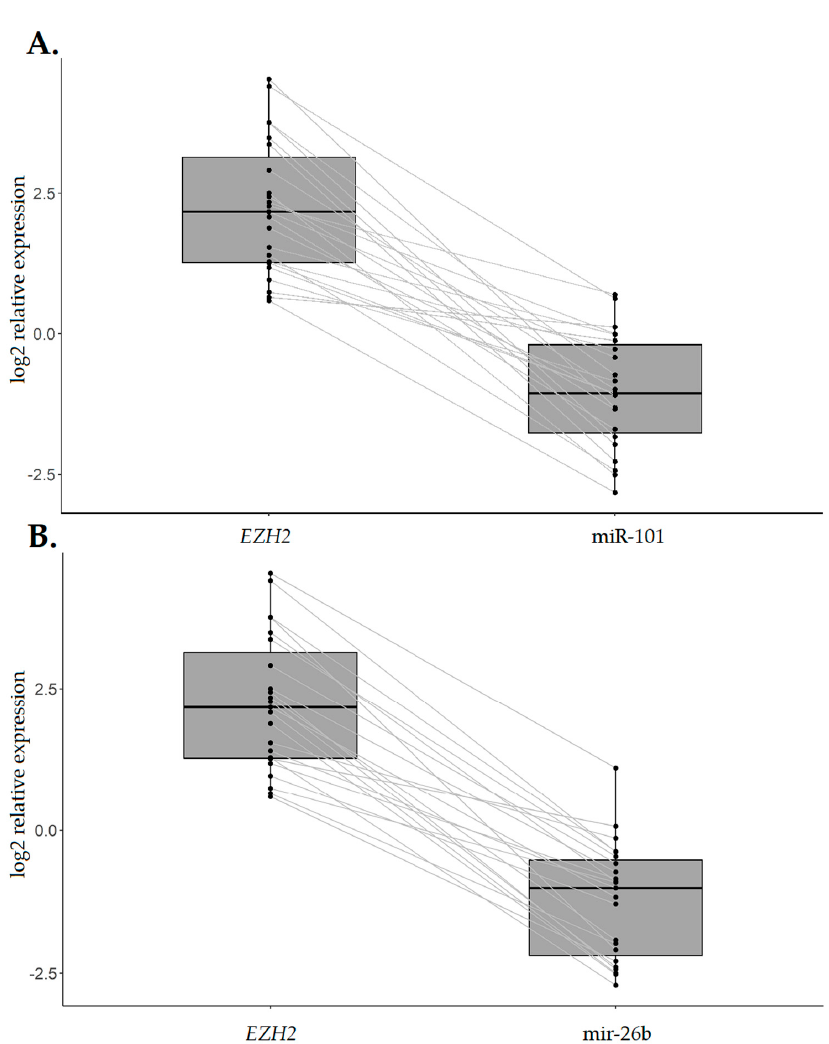
Figure 6. EZH2 overexpression and its association with miR-101 and miR-26b expression. Box plots of miR-101 ( A ) and miR-26b ( B ) expression in relation to EZH2 expression in 23 IGC patients with EZH2 upregulation. Relative expression is measured as log2 FC. p -value < 0.001 (Mann − Whitney test).